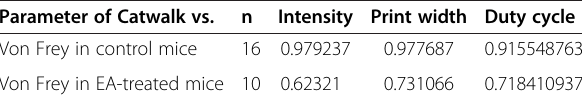
Table 1 Pearson coefficient between the von Frey data and the CatWalk parameters Parameter of Catwalk